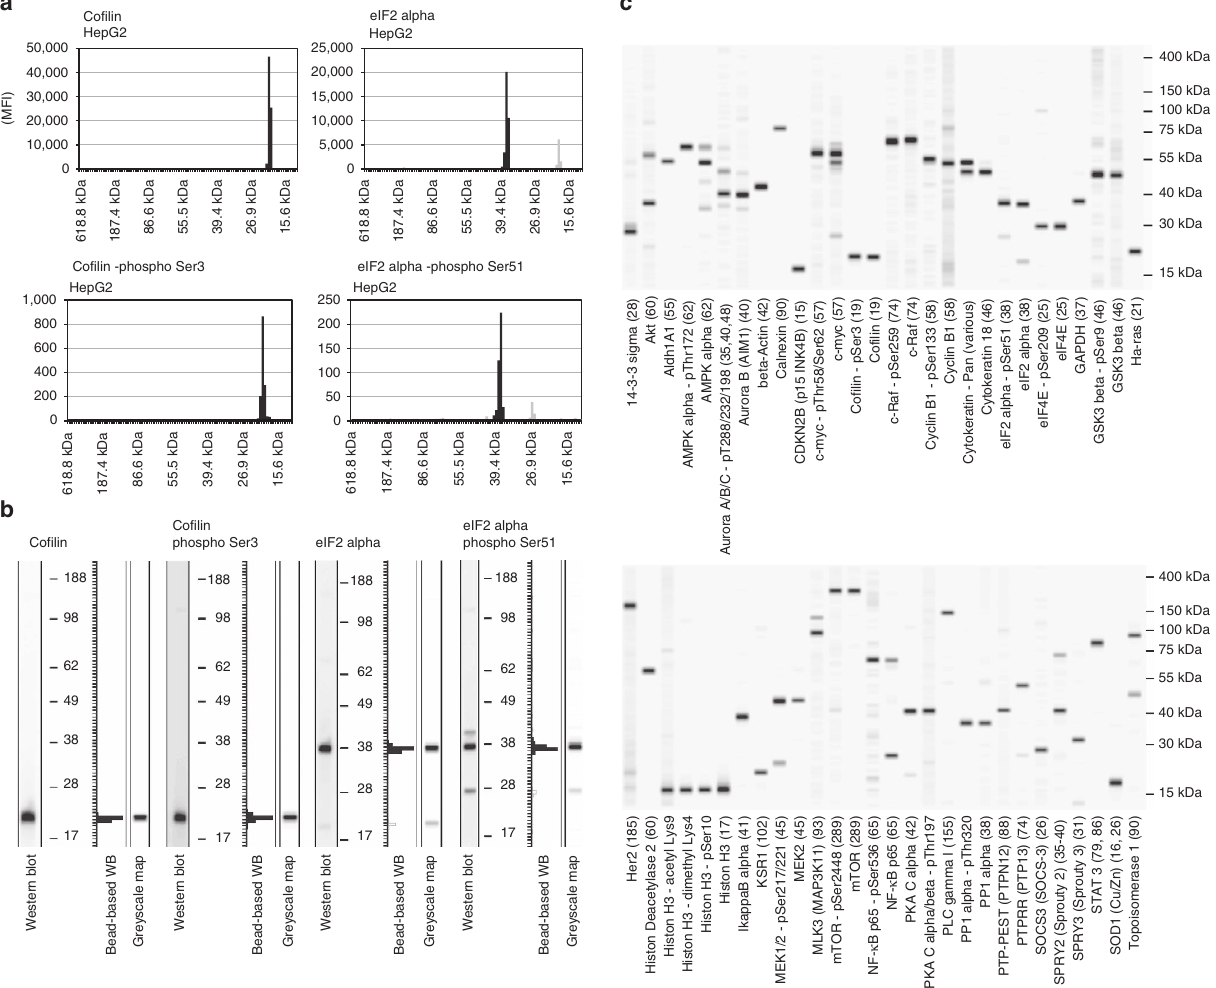
Figure 2 | Comparison with western blot. ( a ) DigiWest: data obtained from 4 antibodies incubated with an aliquot of a bead pool loaded with HepG2 lysate. The 96 molecular weight fractions are represented as graphs. The specific signal is coloured dark grey. ( b ) The same antibodies used against the HepG2 lysate. Classical western blot (left), DigiWest data, illustrated as a graph (middle, same data as in a ), and greyscale maps generated from DigiWest data (right, same data as in a ). ( c ) Greyscale maps generated from 56 antibody incubations on the HepG2-lysate-loaded bead pool. A more comprehensive comparison of 4 100 antibodies on the western blot and DigiWest is provided in Supplementary Fig.